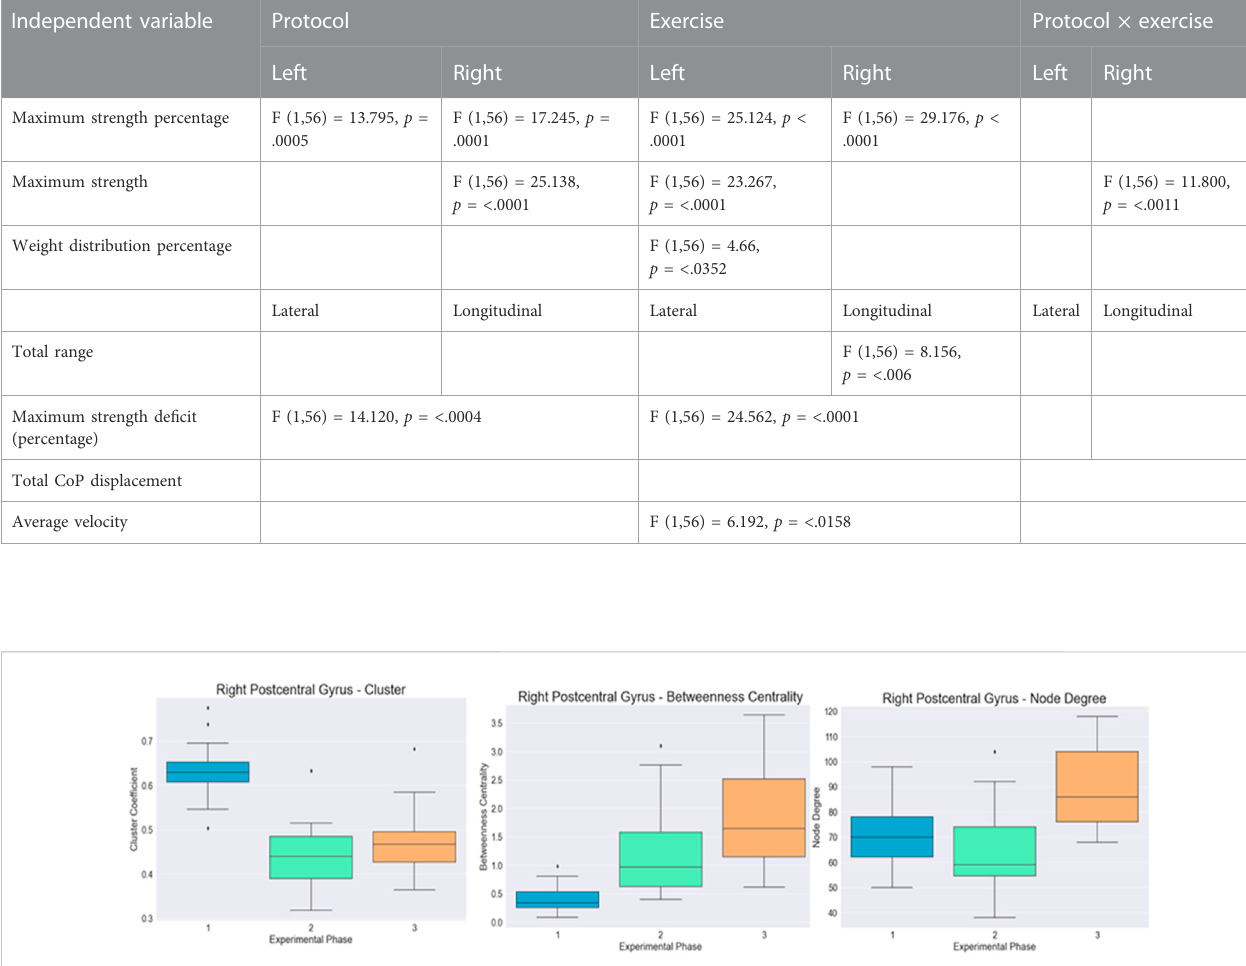
TABLE 4 Visualization of the main effects of protocol, exercise, and their interaction on the various muscle variables. Independent variable